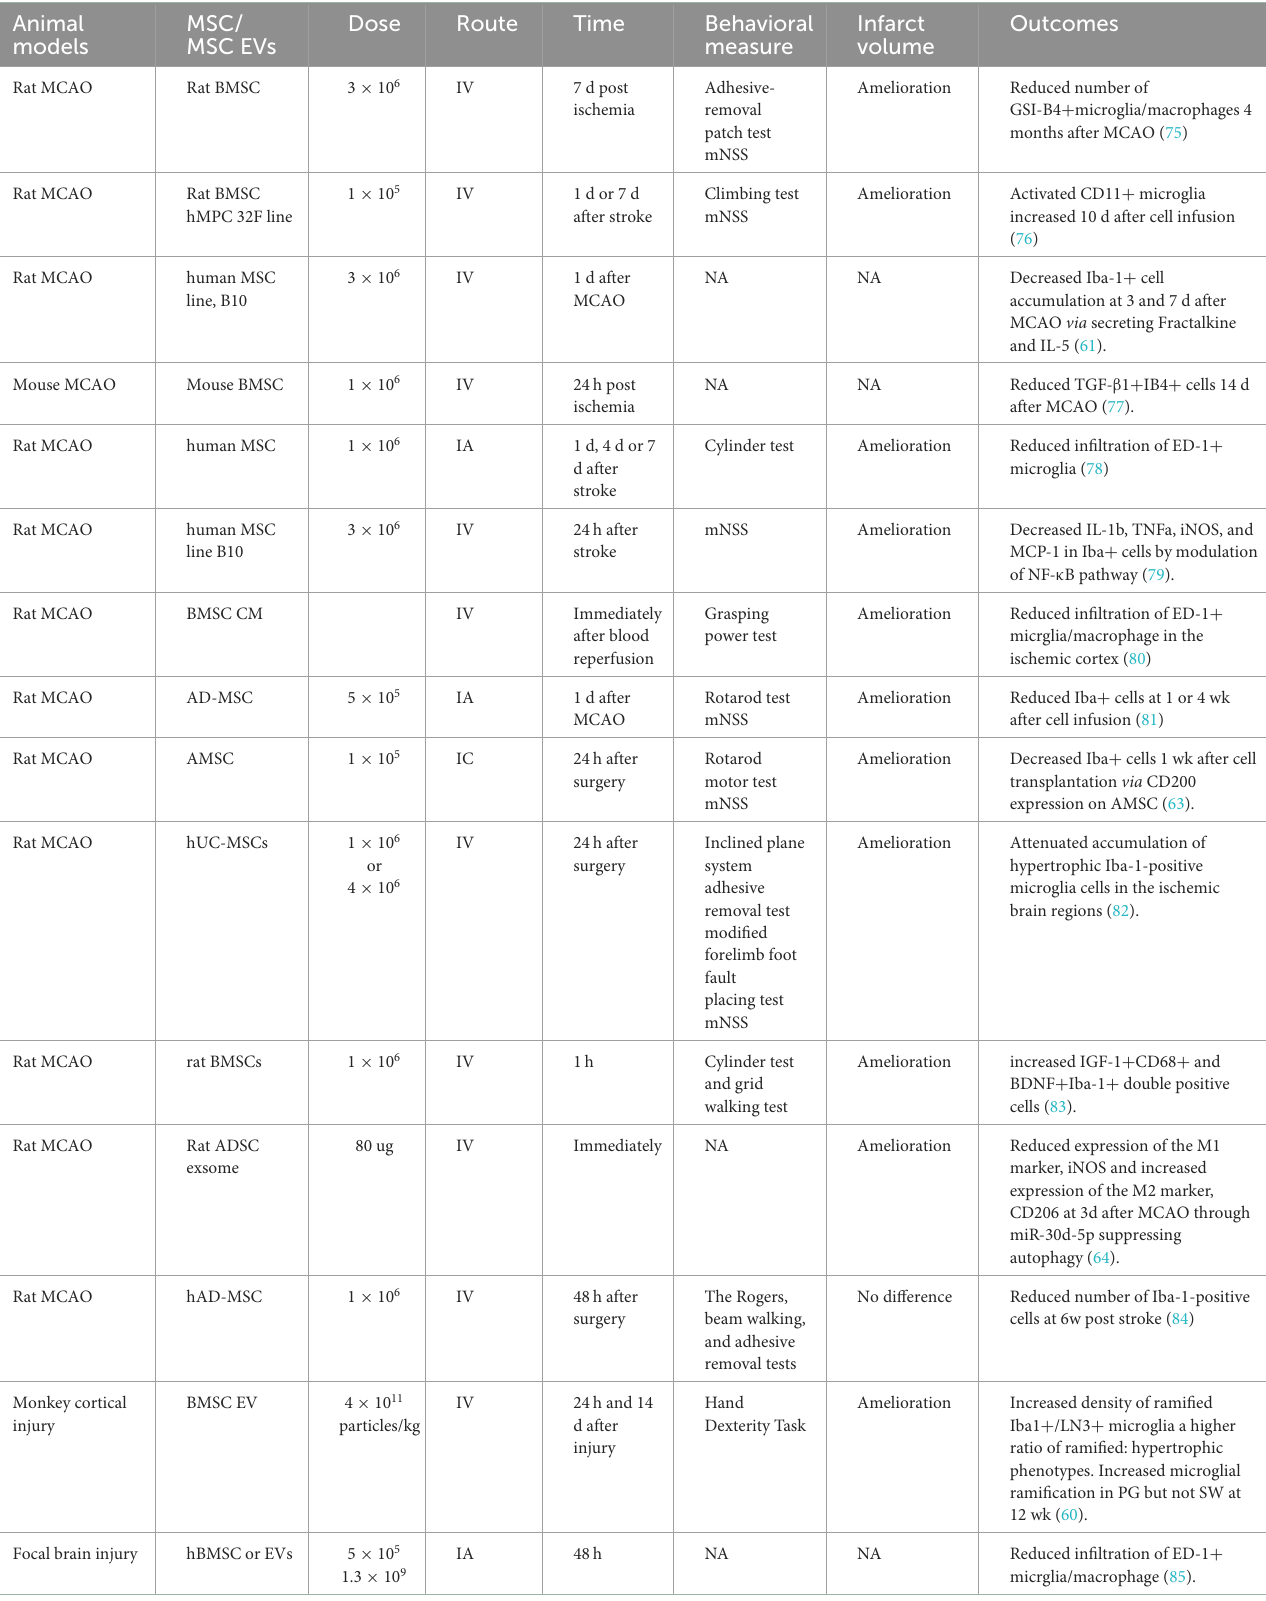
TABLE 2 Therapeutic use of MSC/MSC EVs in preclinical ischemic stroke animal models. Animal